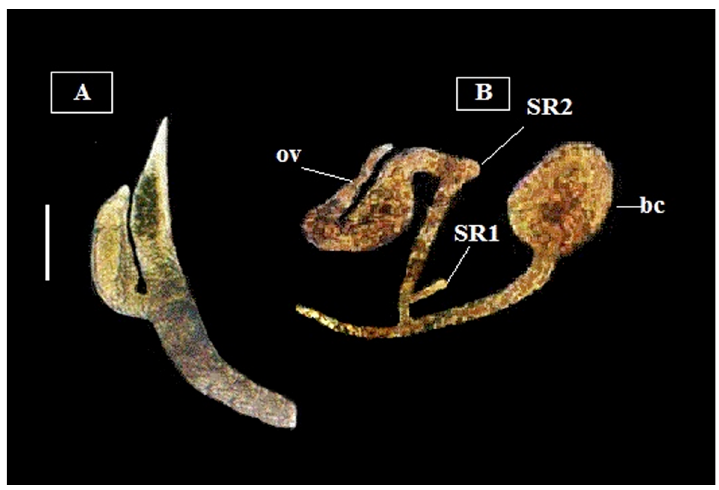
Fig. 5. Genitalia of Bullaregia tunisiensis gen. et sp. nov. A . Penis (paratype). B . Distal female genitalia. Abbreviations: bc = bursa copulatrix; ov = renal oviduct; SR = seminal receptacle. Scale bar 0.1